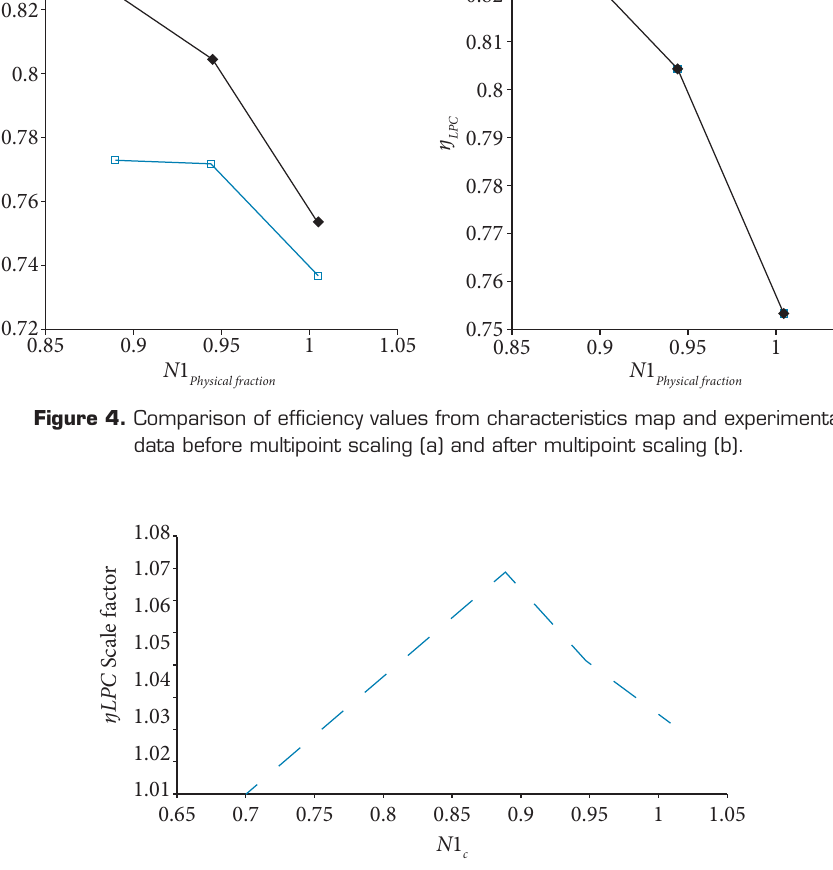
Figure 5. Scale factor to be applied to LPC efficiency